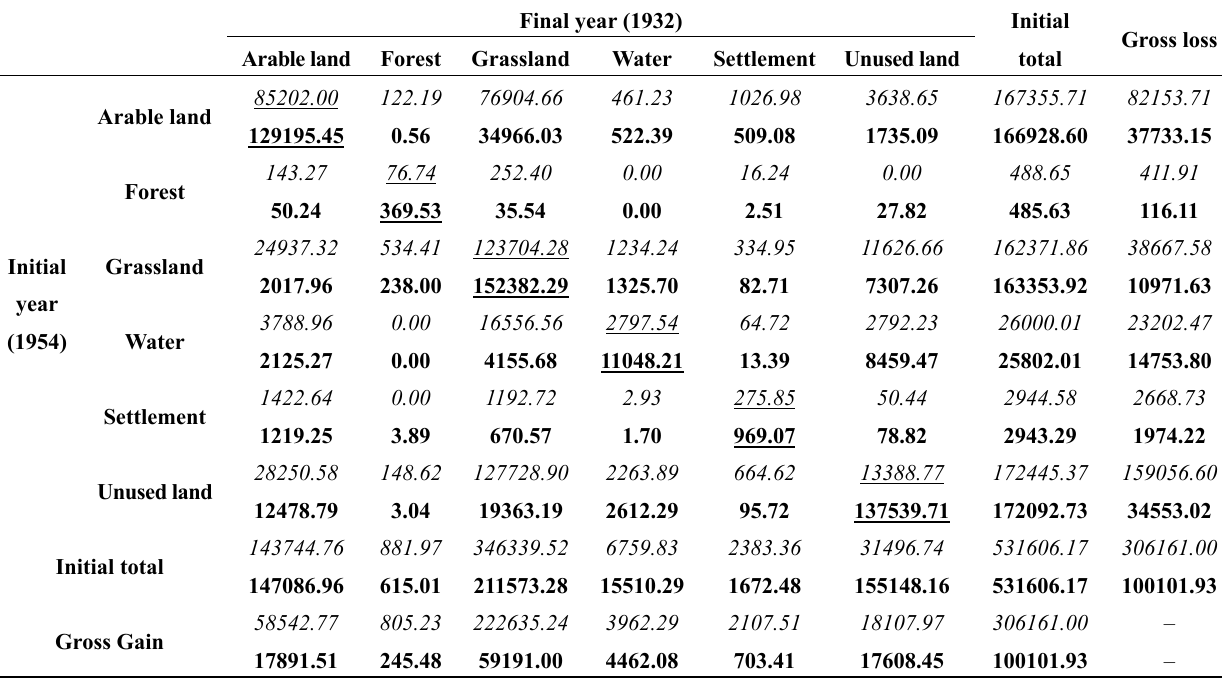
Table 3. Area counts (ha) of persistence on the main diagonal (underlined) and change off the main diagonal from 1954 to 1932: reference change (in italics) and simulated change (in